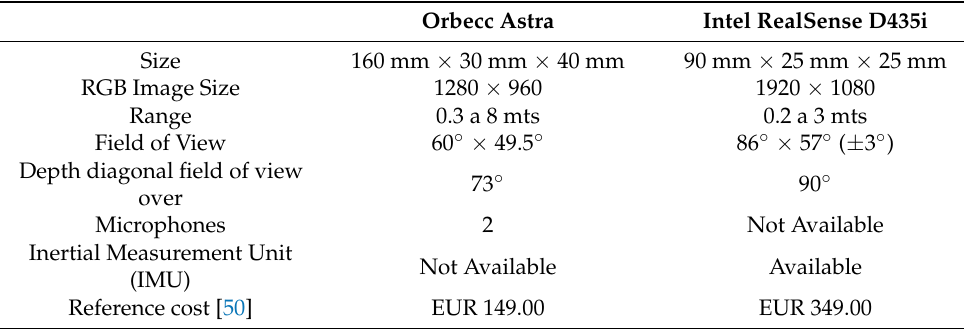
Figure 4. Cameras: ( a ) Intel RealSense D435i. ( b ) Orbbec Astra. Table 2. Camera comparison.